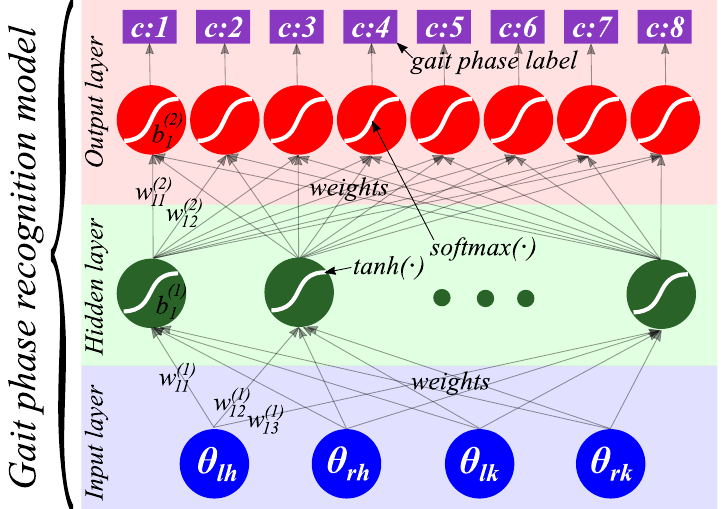
Figure 2. The gait phase recognition model based on multilayer perceptron. The input layer includes a 4-dimensional vector, which corresponds to the four joints from the lower-limb exoskeleton. The middle layer consists of one hidden layer with several hidden units, and the activation function of the hidden unit is tanh ( · ) . The output layer includes eight output units, which corresponds to eight gait phases of one cycle. The function of the output unit is softmax ( · ) . c:1, c:2, ..., c:8 are the labels of the gait